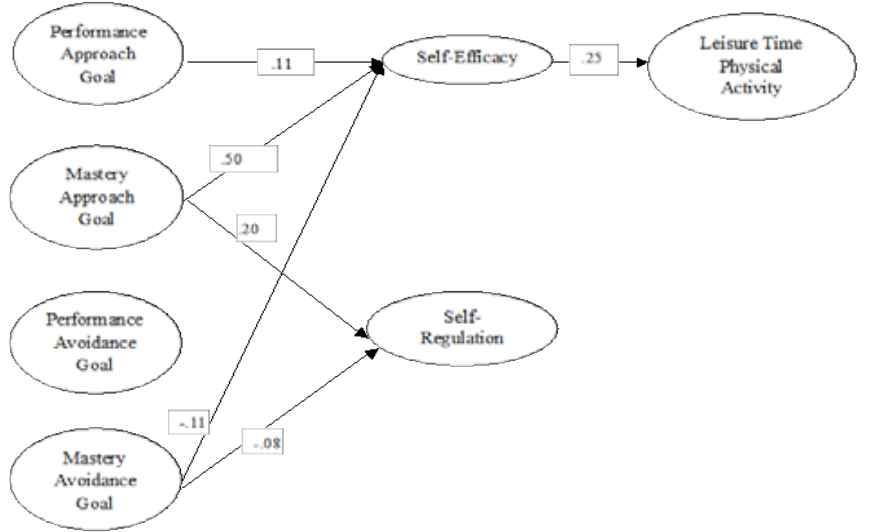
Figure 2. The path model of the interrelationships between LTPA, AG, SR and SE. Note. All coefficients presented are standardized and significant. For visual simplicity variances are not